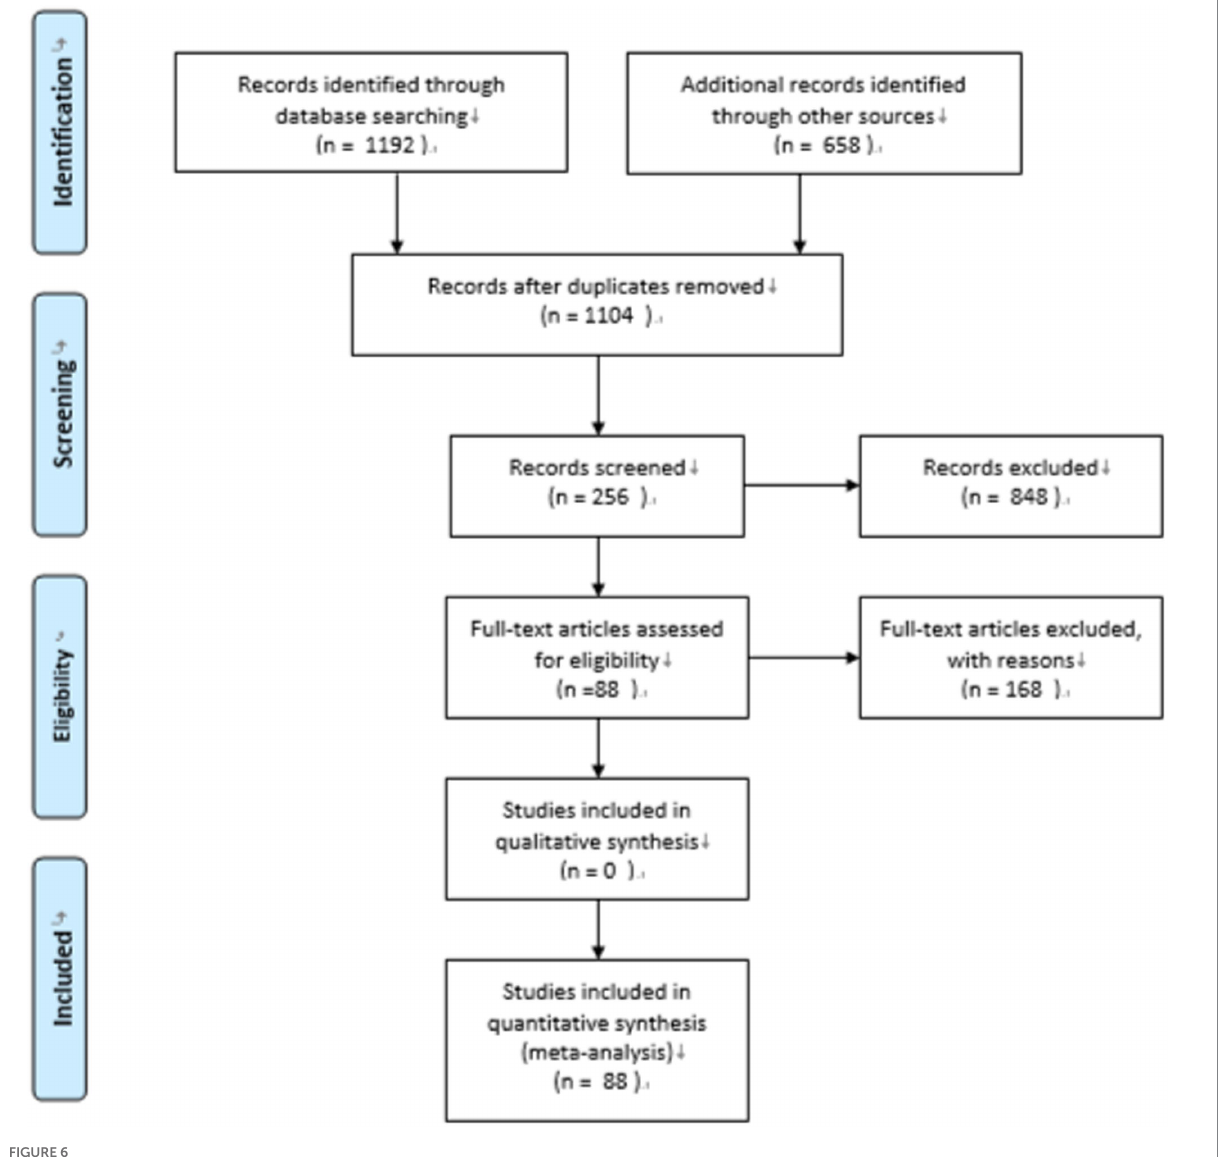
FIGURE 6 A flow diagram for materials